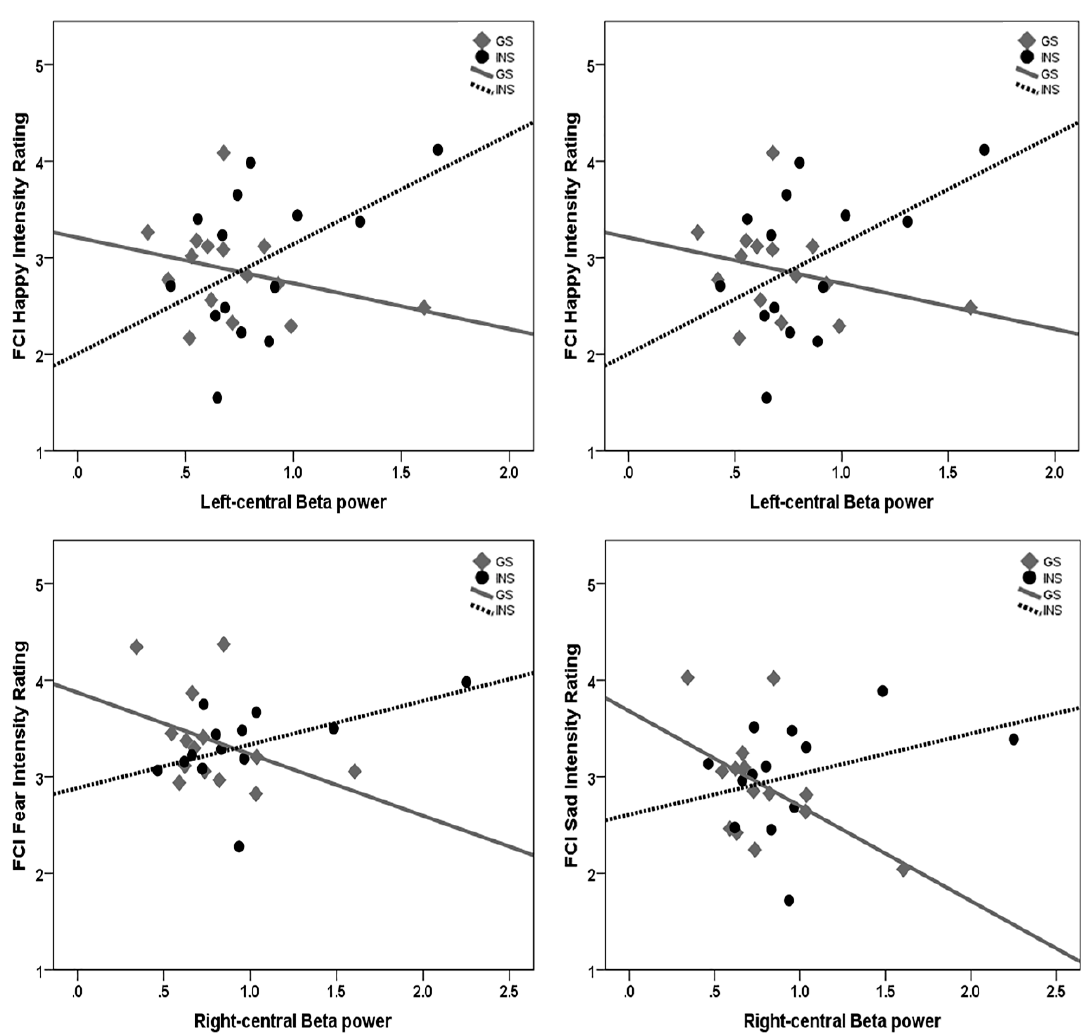
Figure 6. The correlation between frontal beta power and intensity ratings on the FCI for GS and INS groups. Greater frontal beta power was associated with greater intensity ratings of Happy, Fearful and Sad (trending) faces for the INS groups.